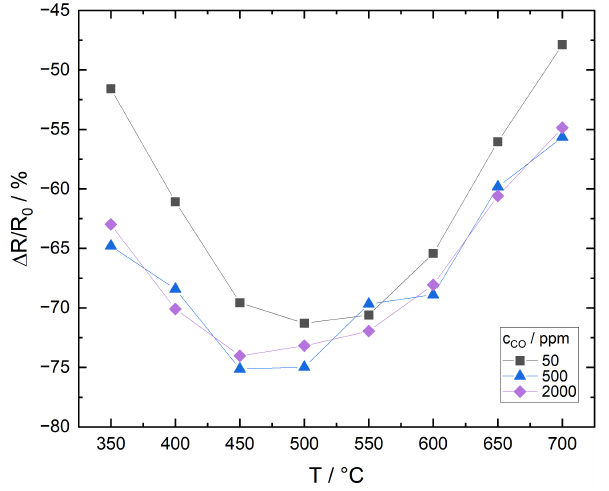
Figure 15. Relative resistance change of ITO thick film as a function of temperature for 3 different CO concentrations, measured in N 2